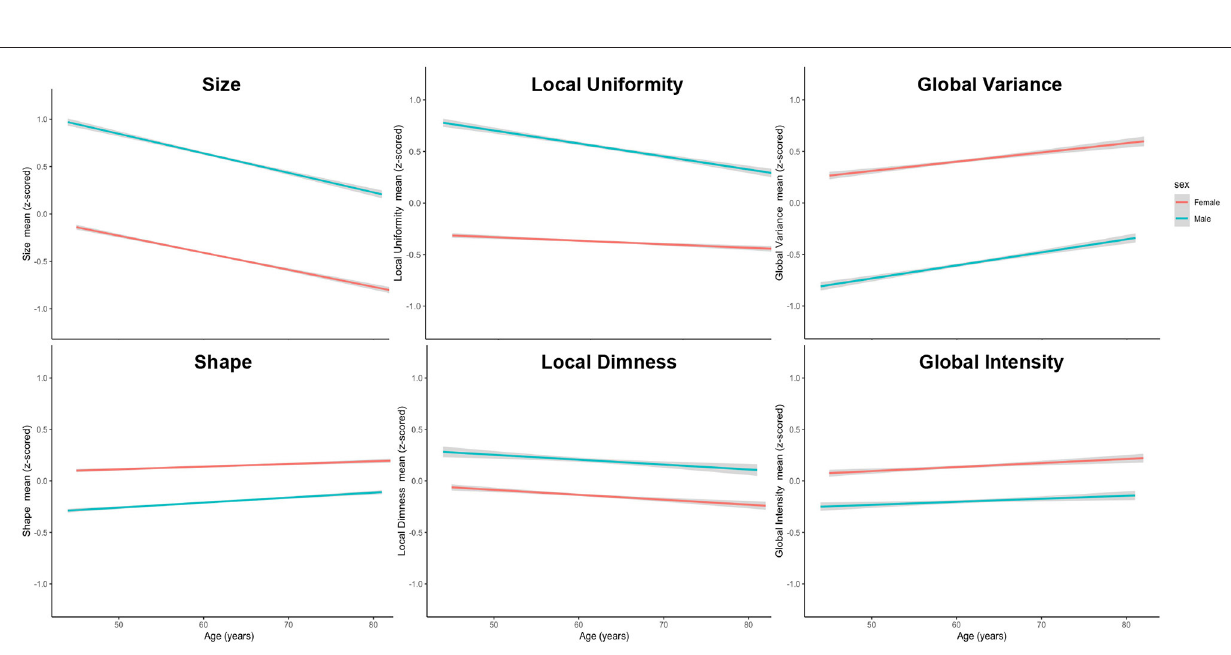
the degree of the association can differ between the sexes ( Supplementary Figure 4 ). As with diabetes, women showed a slightly lower size decrease with high cholesterol compared to